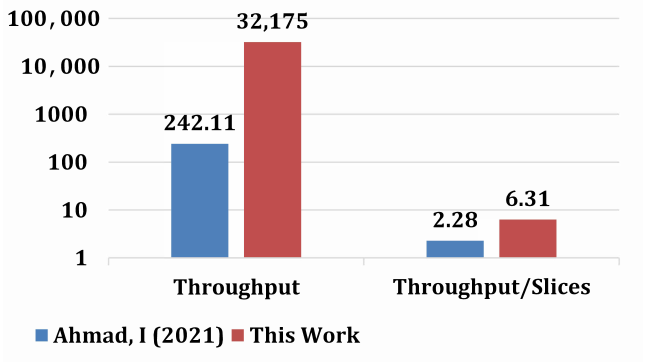
Figure 5. Comparison with [35] in terms of throughput/slices on Virtex-7 FPGA. Comparison with architecture of [33] over ECDH + SIKEX434 algorithms on Artix-7 FPGA